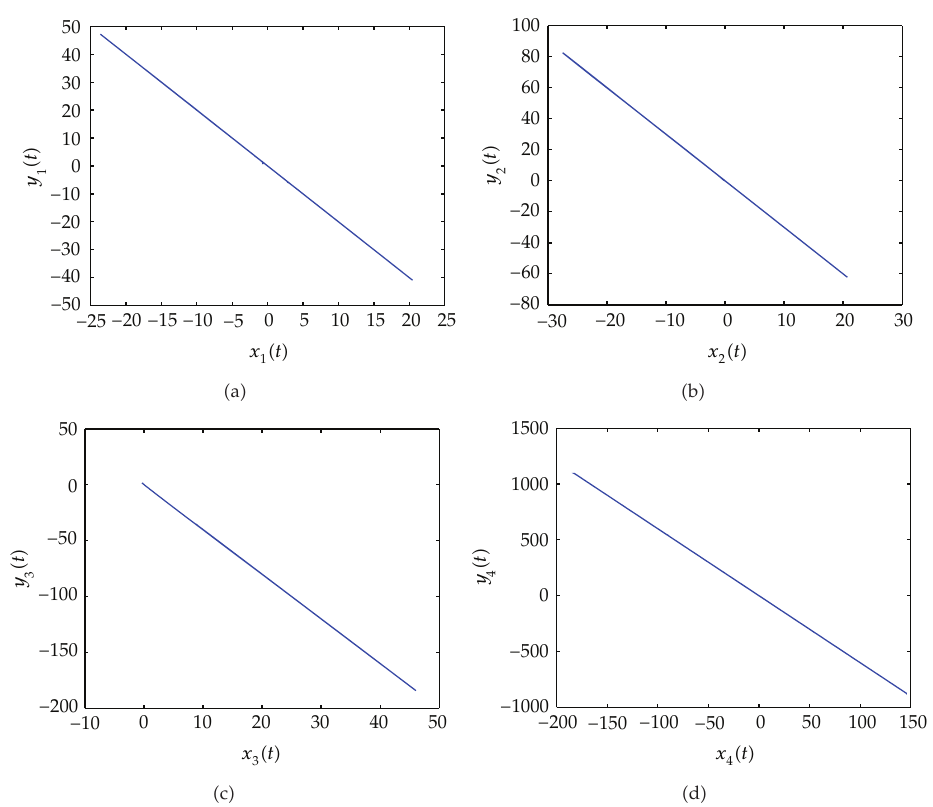
Figure 6: Signals after synchronization under control law (cid:6) 3.5 (cid:7)